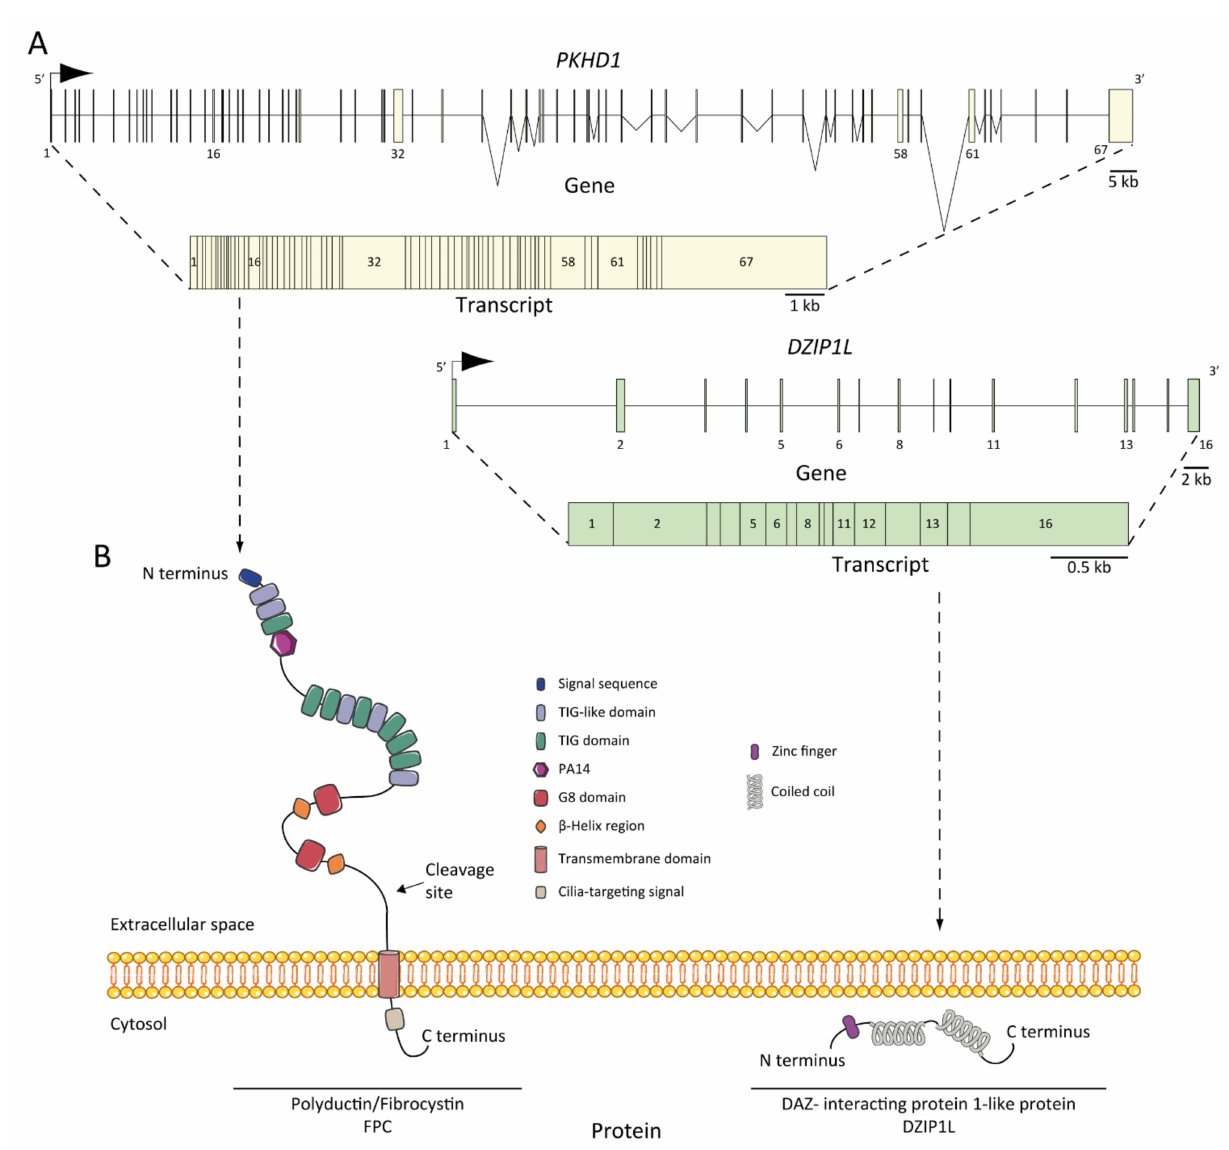
Figure 2. ARPKD genes, transcripts, and proteins: ( A ) PKHD1 and DZIP1L genes and transcripts. The positions of the exons are illustrated and numbered, and the longest transcript are shown from both: 67 exons for PKHD1 and 16 for DZIP1L ; ( B ) structure of fibrocystin/polyductin (FPC) and DAZ-interacting protein 1-like protein (DZIP1L). Proteins are not to